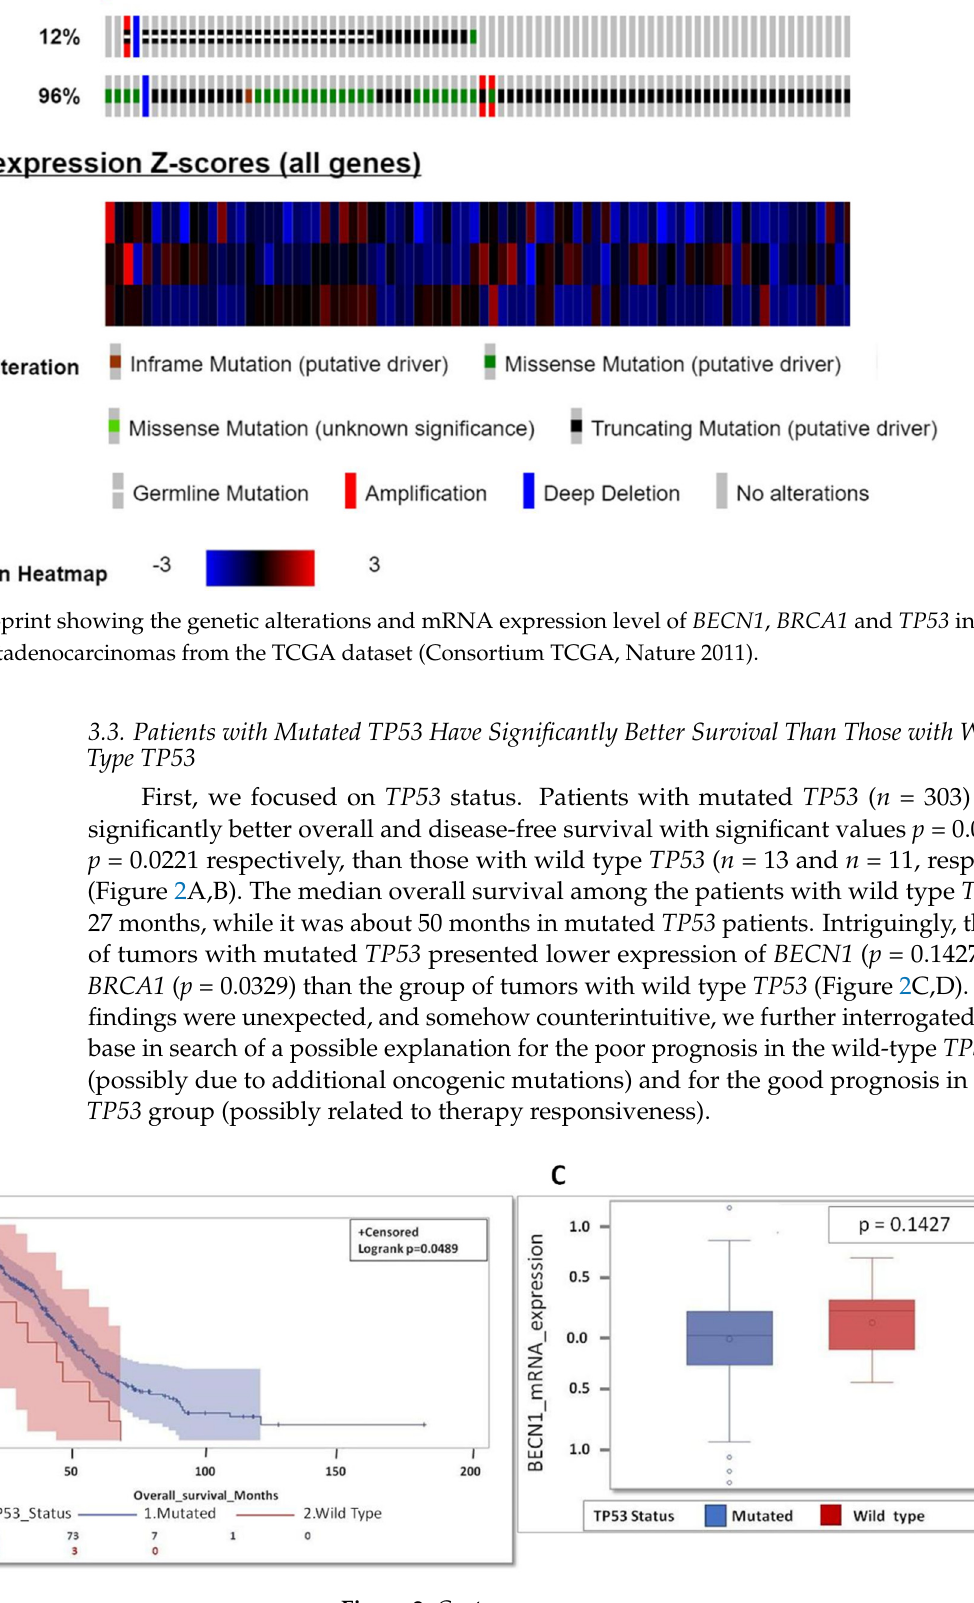
Figure 2. Patients bearing a TP53 -mutated tumor show better prognosis compared to TP53 wild type. ( A ) Overall survival for HGSOC patients according TP53 status. ( B ) Disease-free survival (DFS) for HGSOC patients according TP53 status. ( C ) Box-plot showing the distribution of BECN1 expression according TP53 status. ( D ) Box-plot showing the distribution of BRCA1 expression according TP53 status. (Note that for OS data were not available for 1 patient (mutated group 1 pt: 302 pt’s total n = 303 mutated pt’s) while for DFS data were missing for 56 patients (mutated group 54 pt : 249 pt’s+ wild type group 2 pt’s : 11 pt’s; total n = 316 pt’s), respectively). 3.4. Mutational Profiles of High-Grade Ovarian Serous Cystadenocarcinoma with Wild Type TP53 In the 13 tumor samples with wild type TP53 from TCGA data (validated for somatic mutation status), we identified 490 genes that were mutated (Supplementary Table S2). This list of genes was analyzed by using DAVID bioinformatics functional annotation tool (https://david.ncifcrf.gov/summary.jsp, accessed on 22 nd September 2020) to obtain Gene Ontology (GO) biological processes. We found 267 genes involved in pathogenesis of can- cer, which could have contributed to ovarian carcinogenesis despite the normally func- tioning of TP53 (Supplementary Figure S2). 3.5. BECN1 and BRCA1 Deletions Correlate with High Tumor Stage and Grade Most patients were diagnosed with tumors at stage III and IV (78.4% and 16.8% re- spectively), and of grade G3 (88.9%). As shown in Figure 3, shallow co-deletion of BECN1 and BRCA1 occurs in >83% of the tumors at stage IIIc and IV and of grade 3.